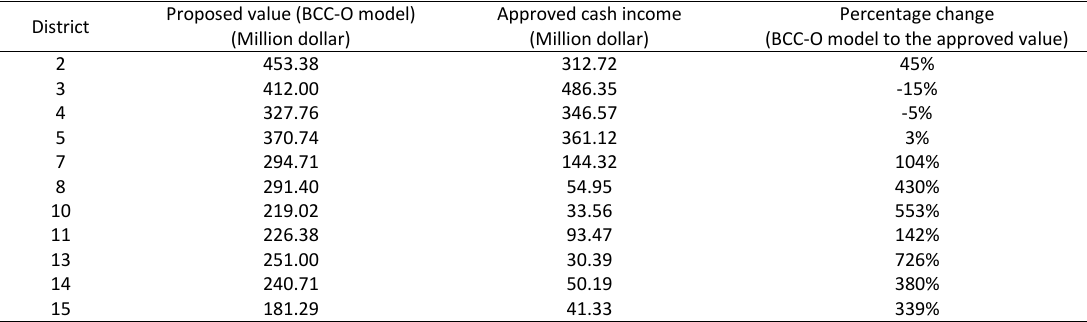
Table 3: The optimized value of cash income based on the BCC-O model District